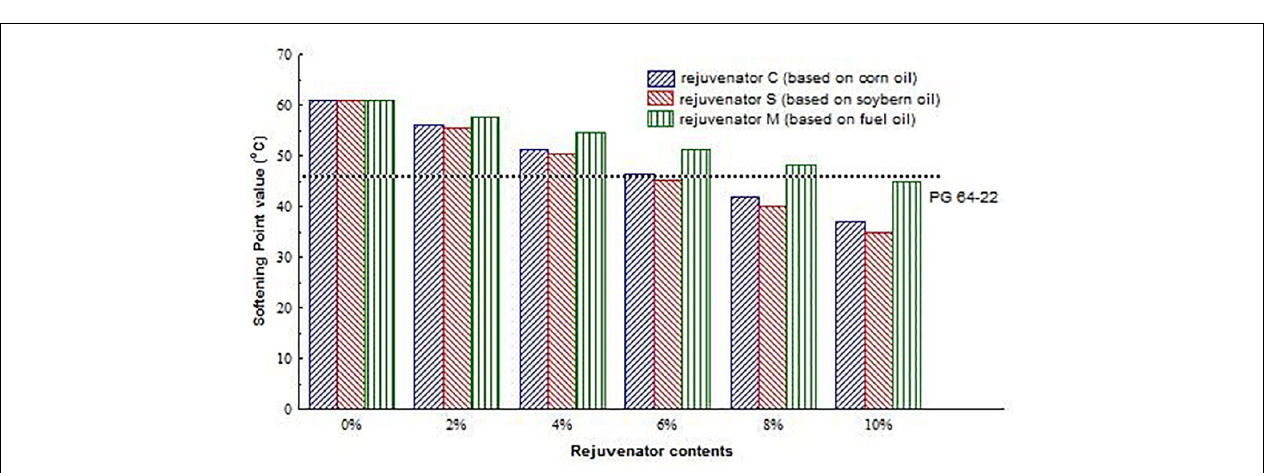
FIGURE 4 | Relationship of softening point value and different